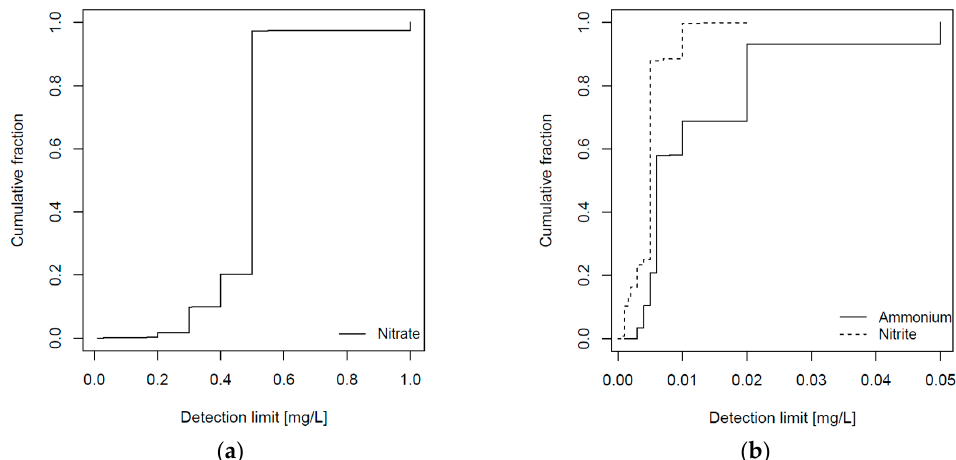
Figure 3. Cumulative fraction of detection limits of samples below the detection limit for ( a ) nitrate ( N = 9144) and ( b ) nitrite ( N = 35,690) and ammonium ( N =